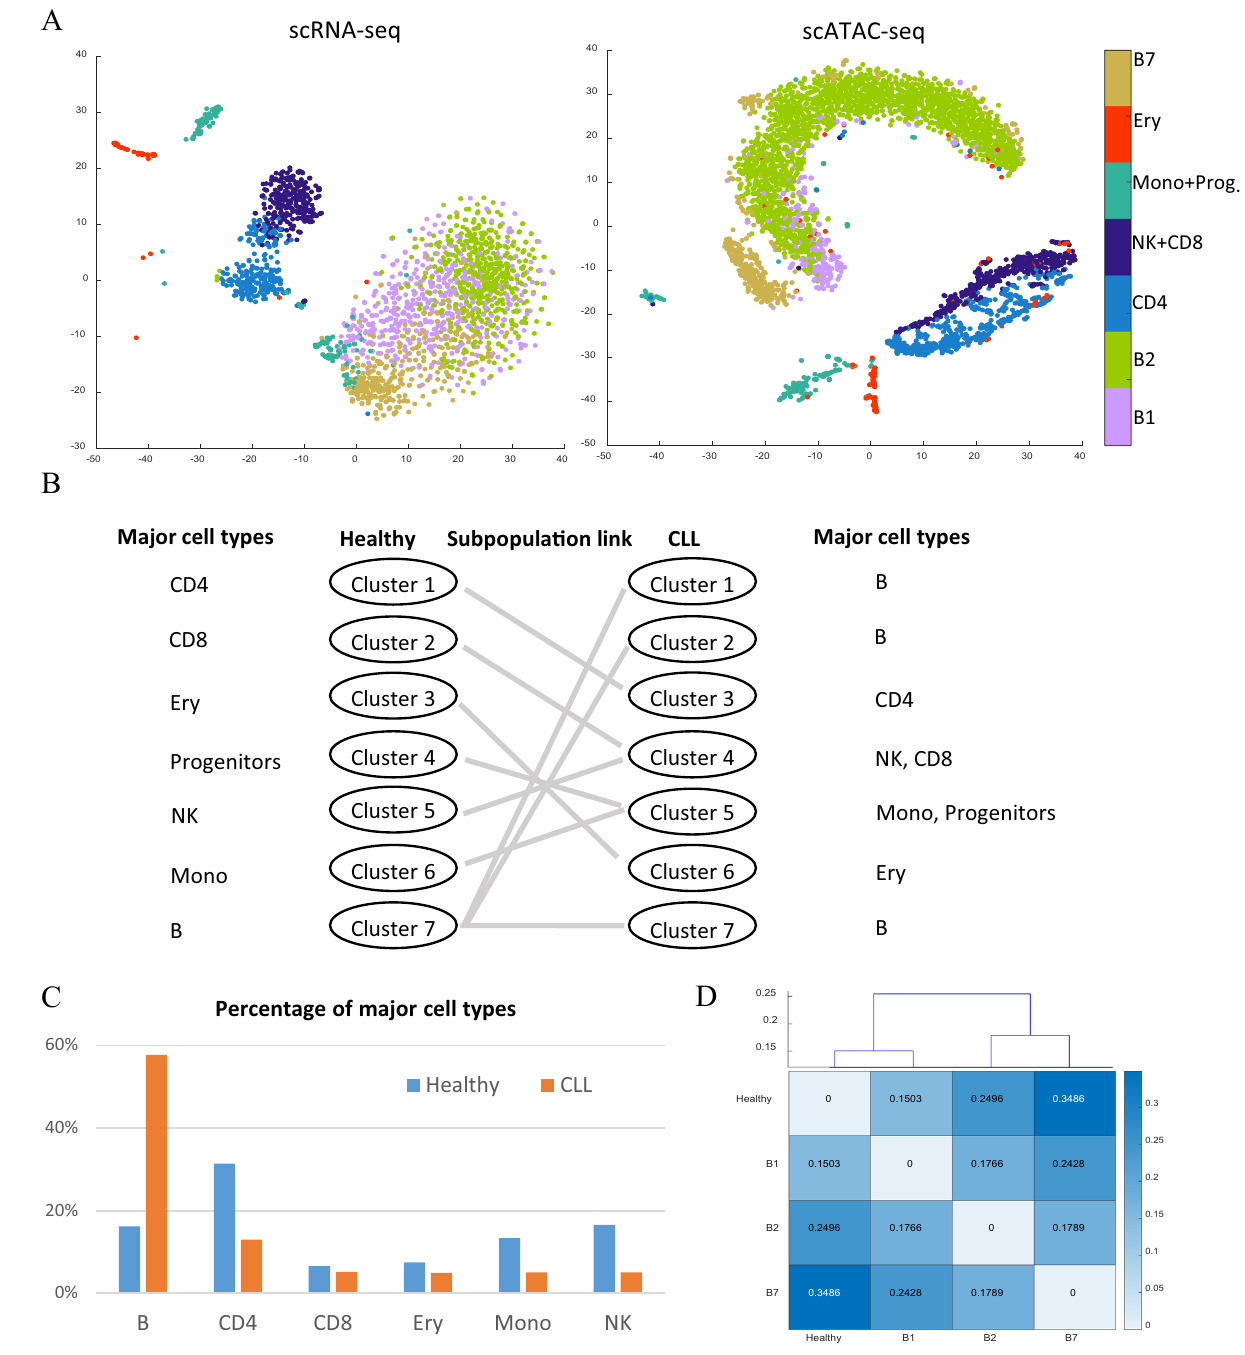
Fig. 4 Comparative analysis of CLL with a healthy donor. A tSNE plots colored with clustering label for scRNA-seq (left) and scATAC-seq (right) on CLL donor. B Cluster mapping between the healthy donor and the CLL donor. We fi nd nine linked subpopulations based on our pro fi le-based pairing method. The label in the bracket represents dominant surrogate ground truths. The result from pro fi le-based pairing is completely consistent with the surrogate ground truths-based mapping. Please see “ Linking of subpopulations across conditions ” in the “ Methods ” section. C The fraction of cell types in healthy donor and CLL donor based on the constructed true labels. D Clustering of B cell subpopulation based on the joint pattern of markers CD19, CD23, and CD69. The numbers represent the Hellinger